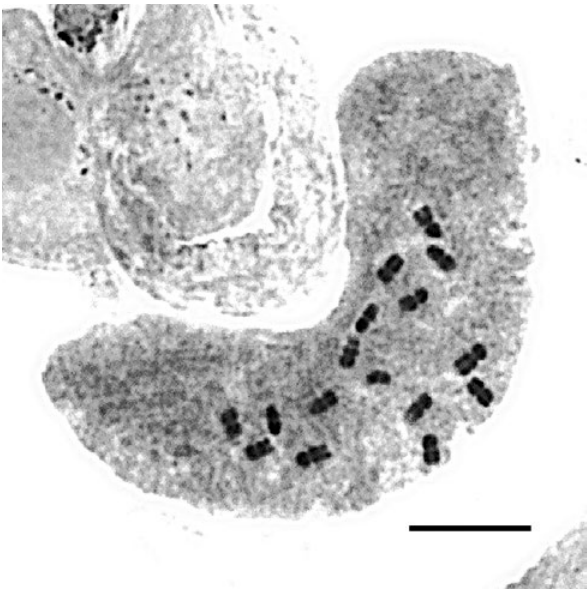
Figure 2. Mitotic metaphase chromosomes of Agrimonia pilosa Ledebour (Beijing, China), 2 n = 16. Scale bar = 10 µm.